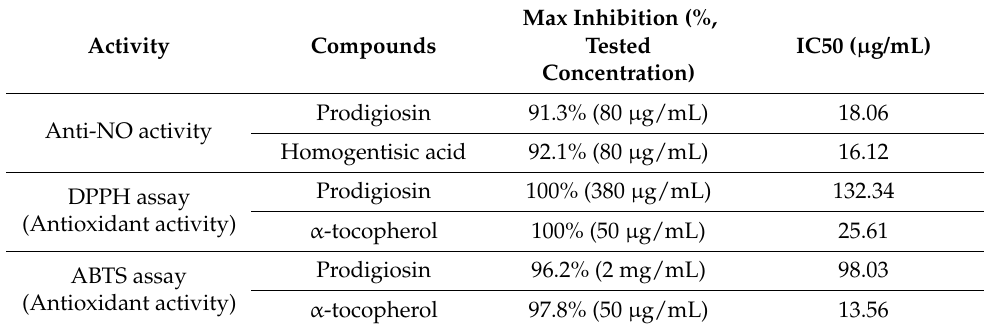
Table 3. The anti-NO and antioxidant effects of prodigiosin.